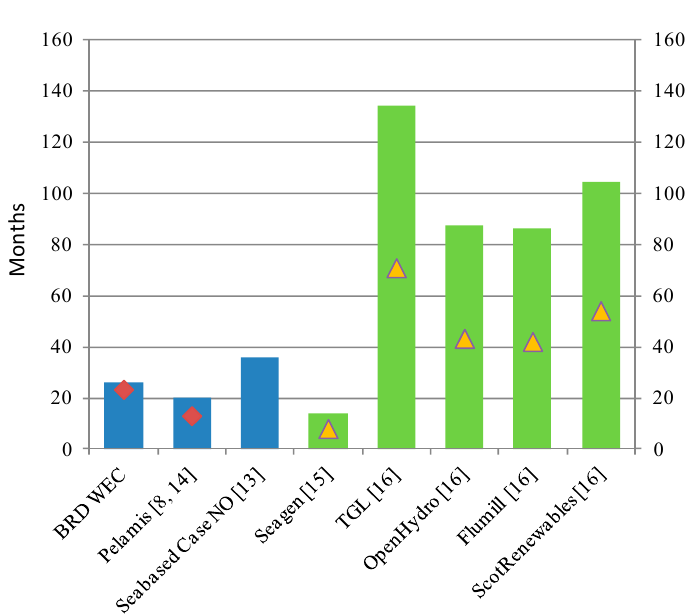
Figure 5. Comparison of energy and carbon paybacks of wave and tidal energy converters.